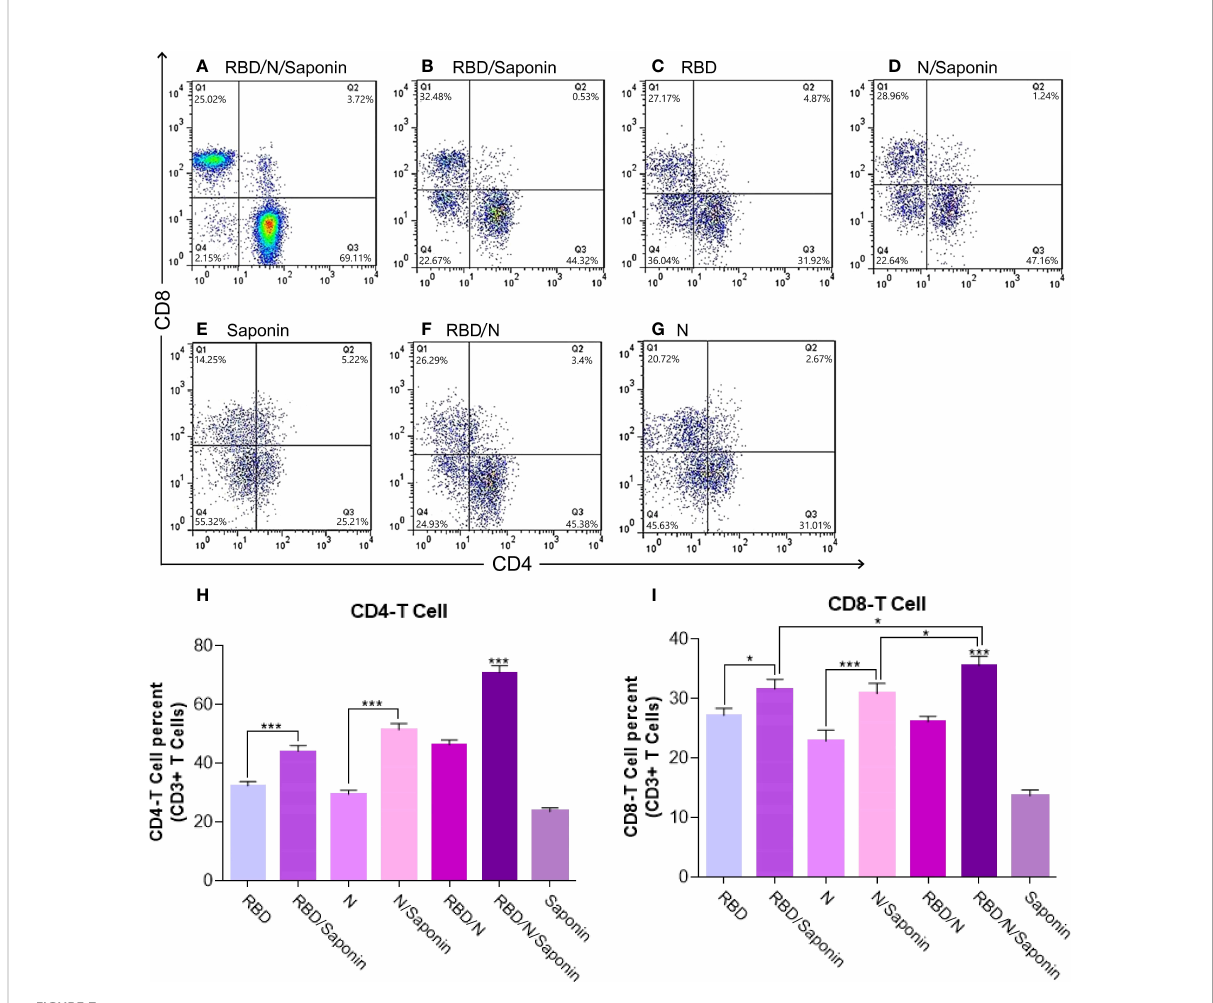
FIGURE 7 Flow cytometry analysis of levels of CD3 + CD4+ and CD3 + CD8+ T cells in immunized mice. Mouse spleen mononuclear cells were isolated by density gradient centrifugation on Ficoll-Paque. Three different colors were used for CD3+, CD4+ and CD8+ membrane markers. Gated CD3 positive events were analyzed for CD4 and CD8 production (A-G). The graph of fl ow cytometry represents data of fi ve experiments with similar results (H, I). The data represent the means ± standard deviation (SD). Statistical analysis between the four groups were analyzed by one- way ANOVA (*p < 0.05, ***p <